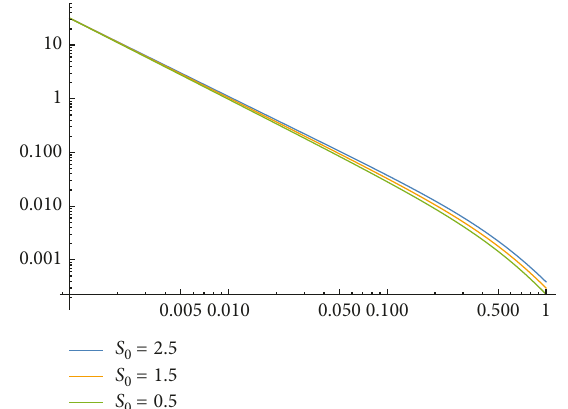
Figure 5: Log-log plot of the distribution (15) for I ε � 0 . 75, and three different S